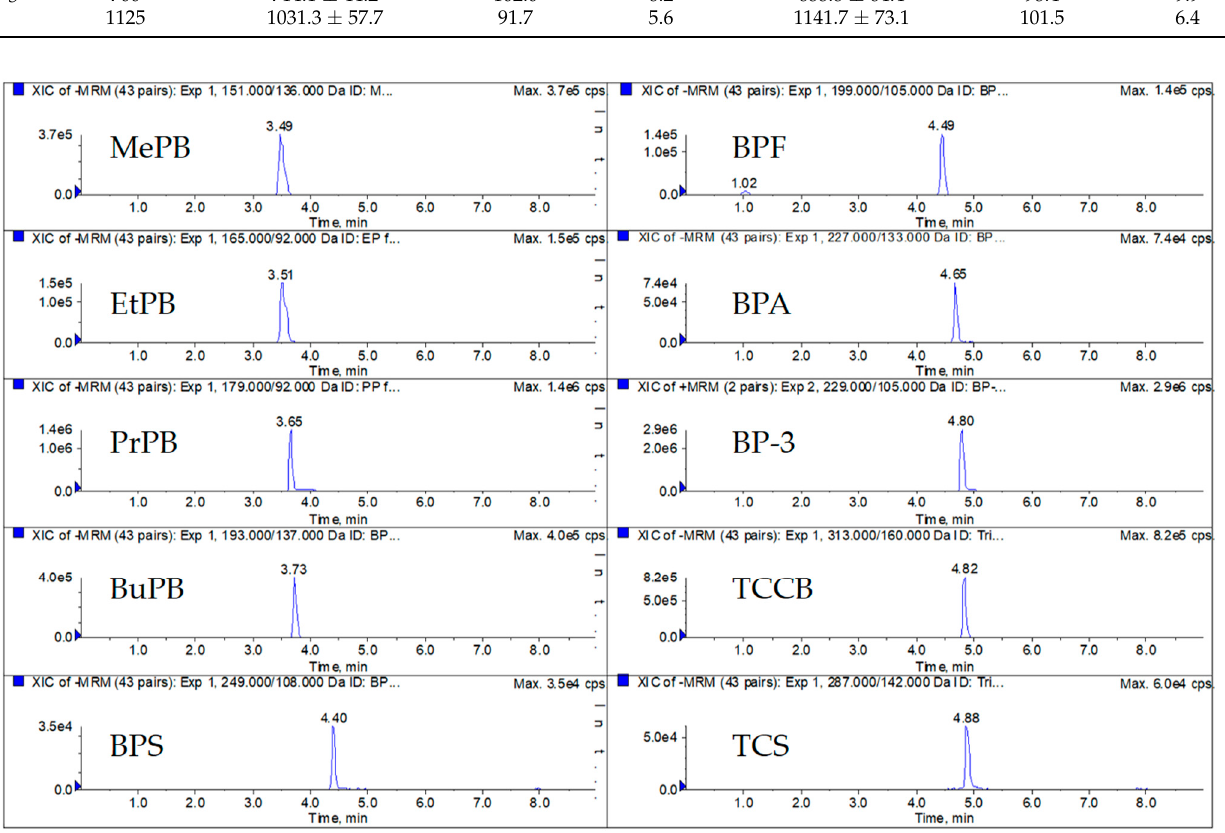
Figure 1. UPLC-MS/MS method chromatograms of target EDCs in an adolescent urine sample. Table 5. Distribution of parabens, bisphenols, triclosan and benzophenone in urine of children and adolescence.